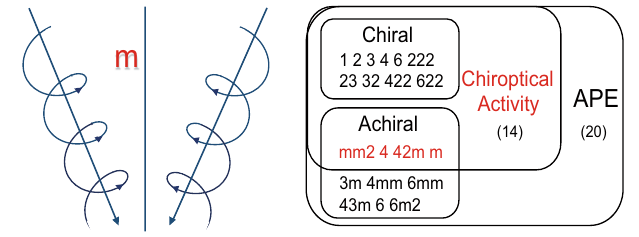
Fig. 1 | Analysis relatedtopoint group. Chiropticalactivity from an entity with m point group (Left); Relationship between point group, chiroptical activity and APE